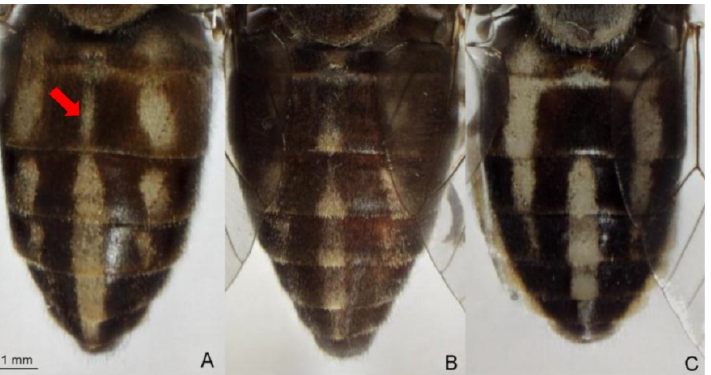
Figure 1. Morphological characteristics of abdominal dorsum used to distinguish species of Tabanus megalops ( A ), T. rubidus ( B ), and T. striatus ( C ). Tabanus megalops and T. striatus are distinguished by the midline of the 2 nd tergite cross by a stripe of pale tomentum and hairs in T. megalops (arrow).